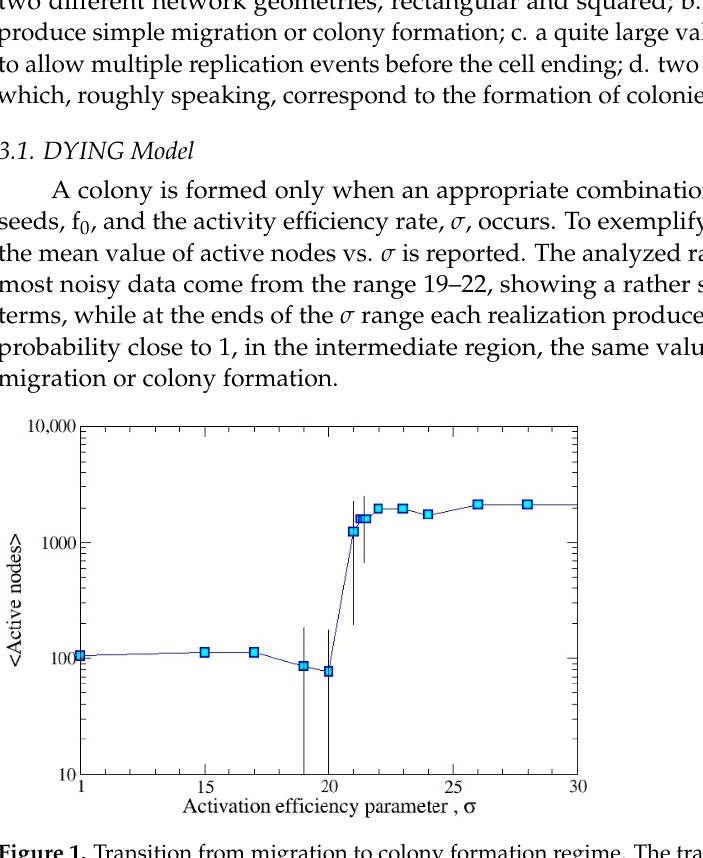
Table 1. Model parameters. We briefly recall their meaning and the values adopted in simulations.